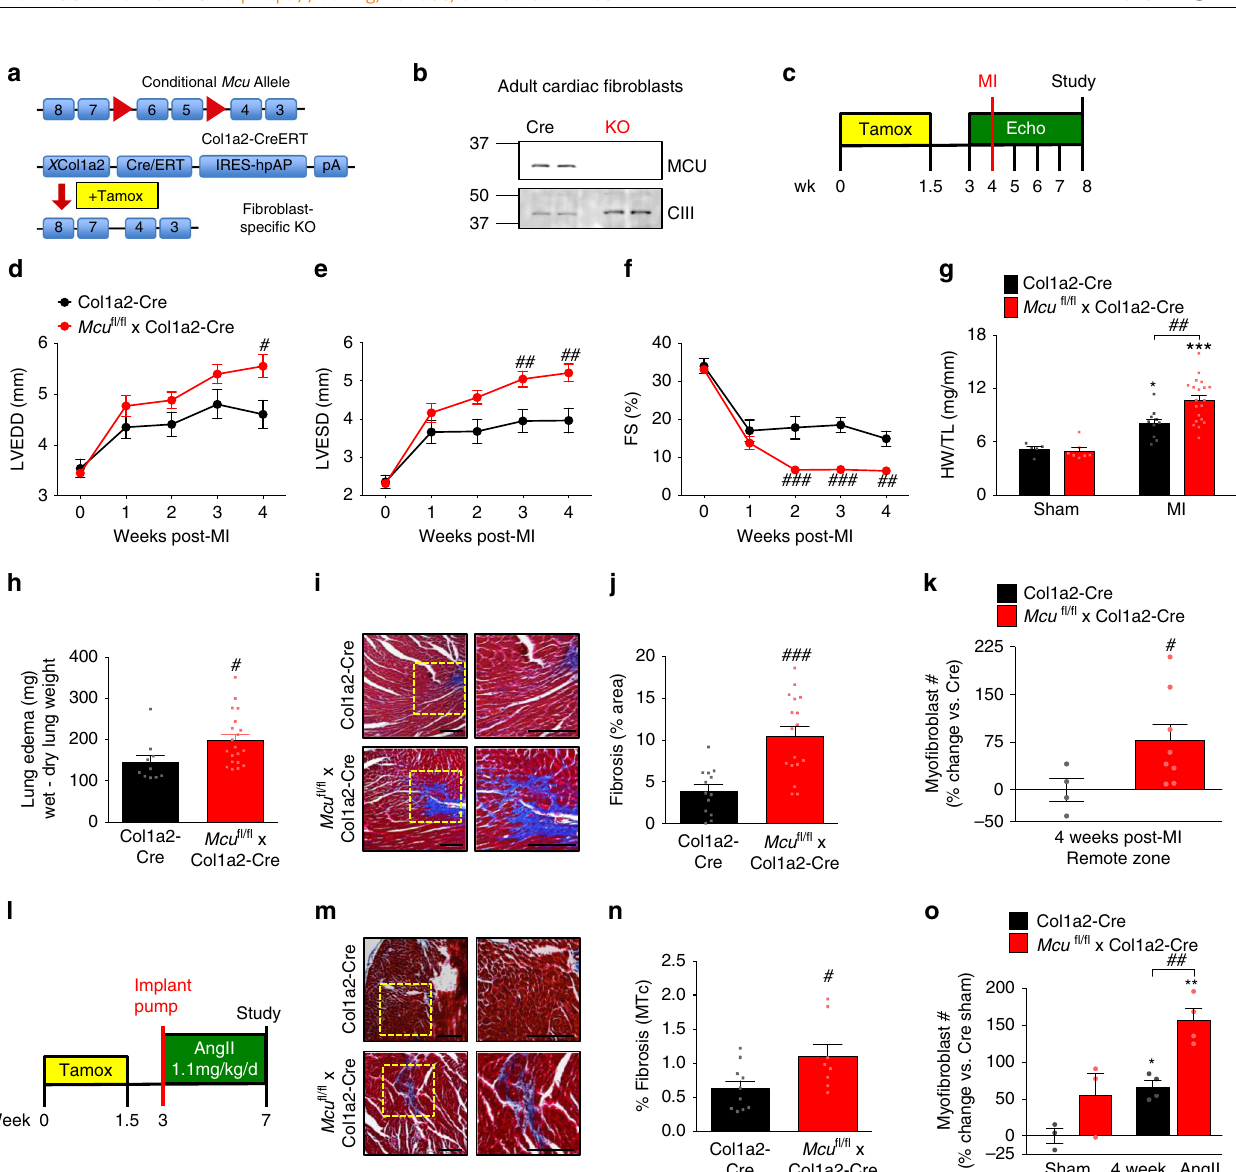
secondary antibodies, membranes were washed in TBS-T 3 times for 5min each